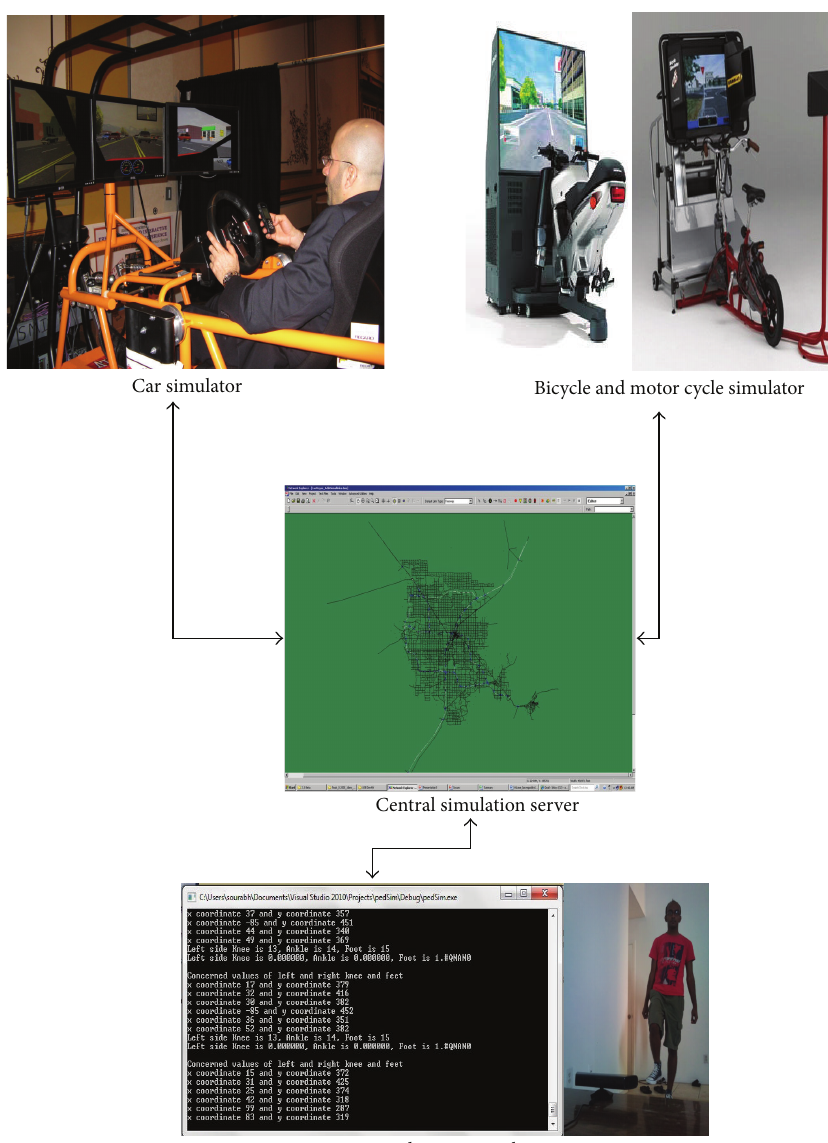
Figure 1: System architecture of n-MIPEDS. (The images for the bicycle and motorcycle simulators are used here for illustrative purposes only. Copyright: